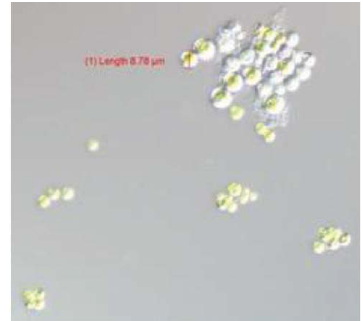
Fig. 6c. Morphological observation of Chlorella vulgaris NIES-1269 with 40X